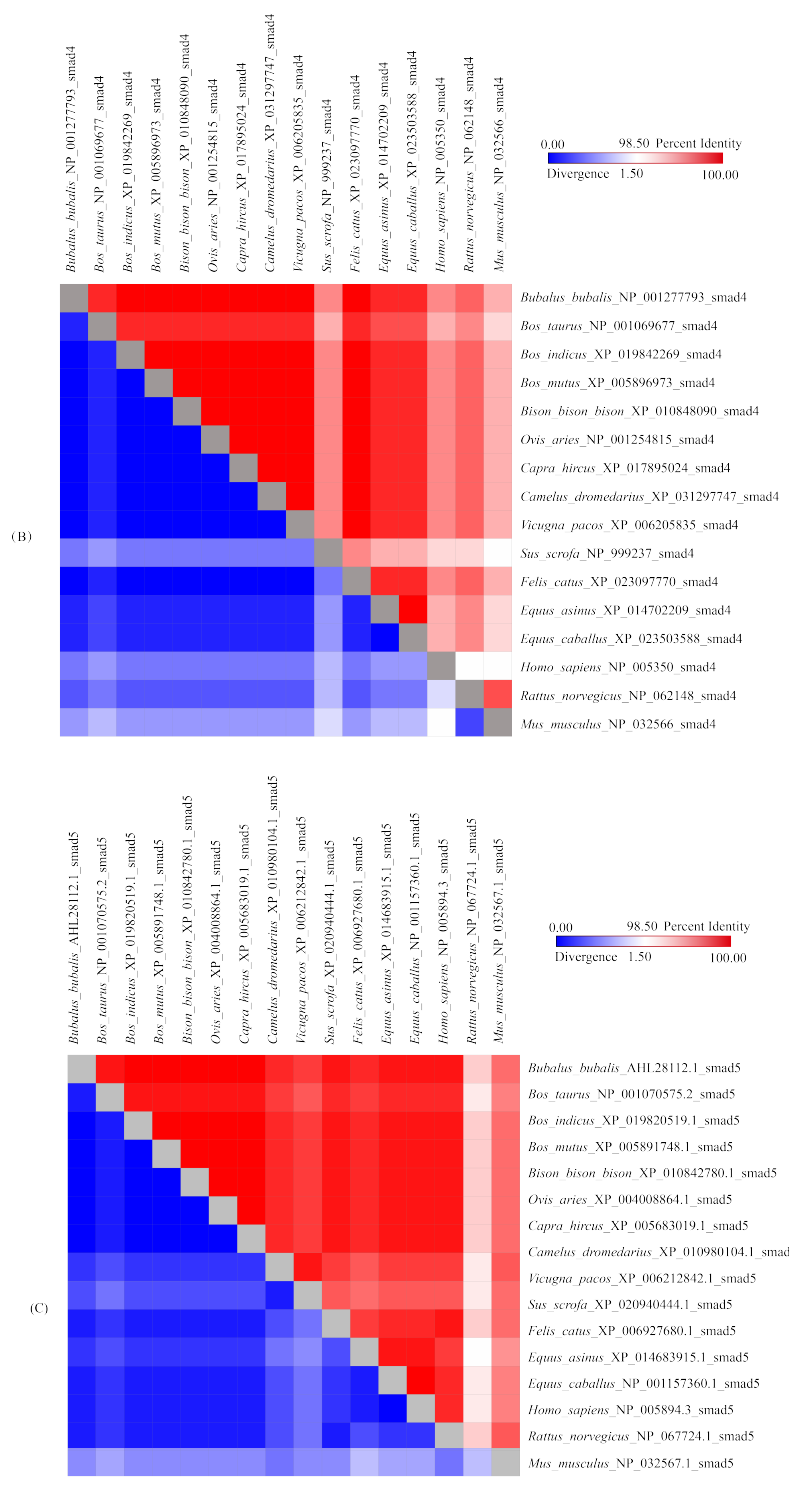
Figure 4. Divergences and percent identities according to the AASs of Smads 1 , 4 , and 5 between buffalo and other species. ( A ) Smad1 , ( B ) Smad4 , and ( C ) Smad5 . The divergences and percent identities were shown in the upper and lower triangle of the matrix,